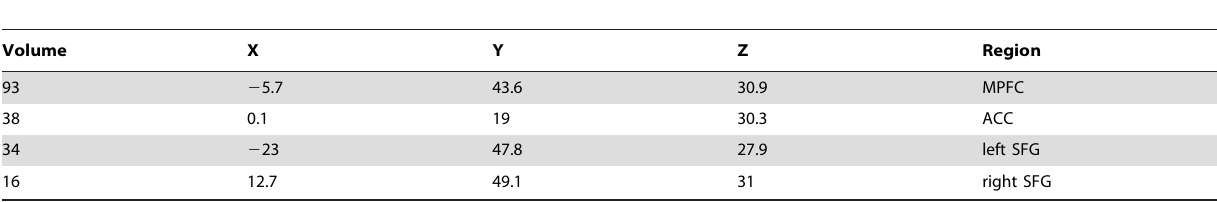
Table 2. Brain activations shown in the conjunction analysis (cluster